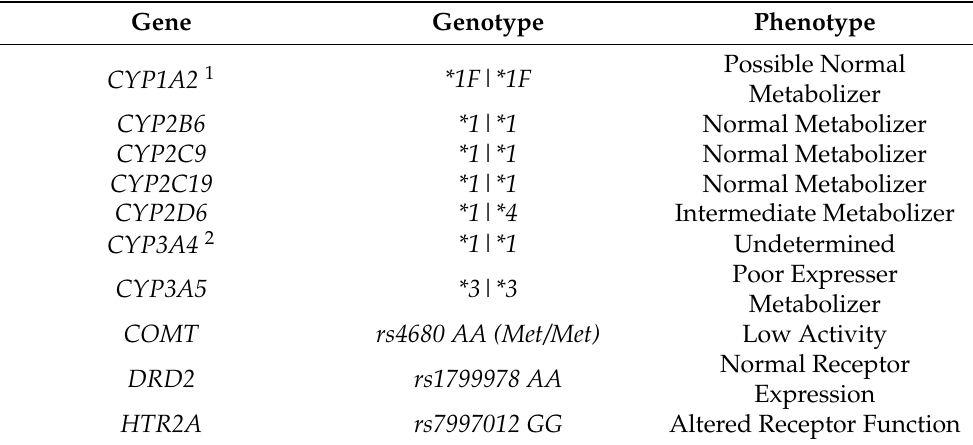
Table 1. Patient’s Pharmacogenomics Test